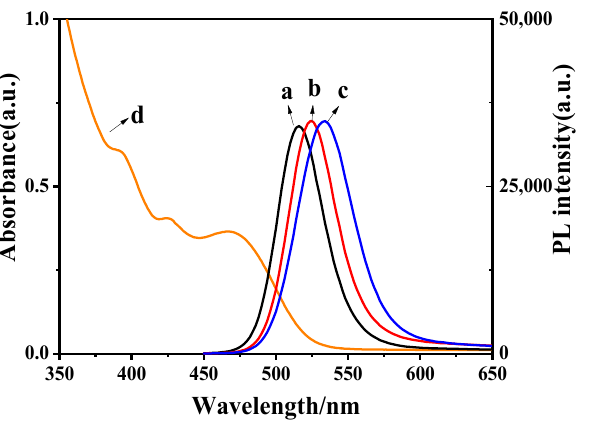
Figure 1. Fluorescence and absorption spectrum of CdTe QDs (curves a , b and c : fluorescence emission peak; curve d : ultraviolet absorption peak—the reflux times of curves a , b and c are 2 h, 4 h and 6 h, respectively).